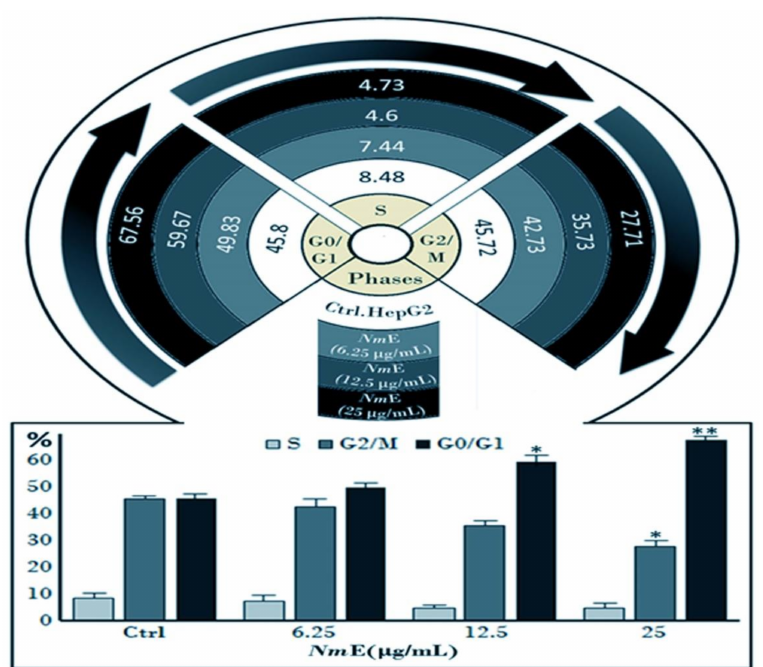
Figure 10. Schematic drawing and bar chart for the cell cycle analysis expressed by (%) of HepG2 cells in each phase when treated with Nm E. Bars represent the means ± SD. * p < 0.05 and ** p < 0.01, vs. control (DMSO-treated)